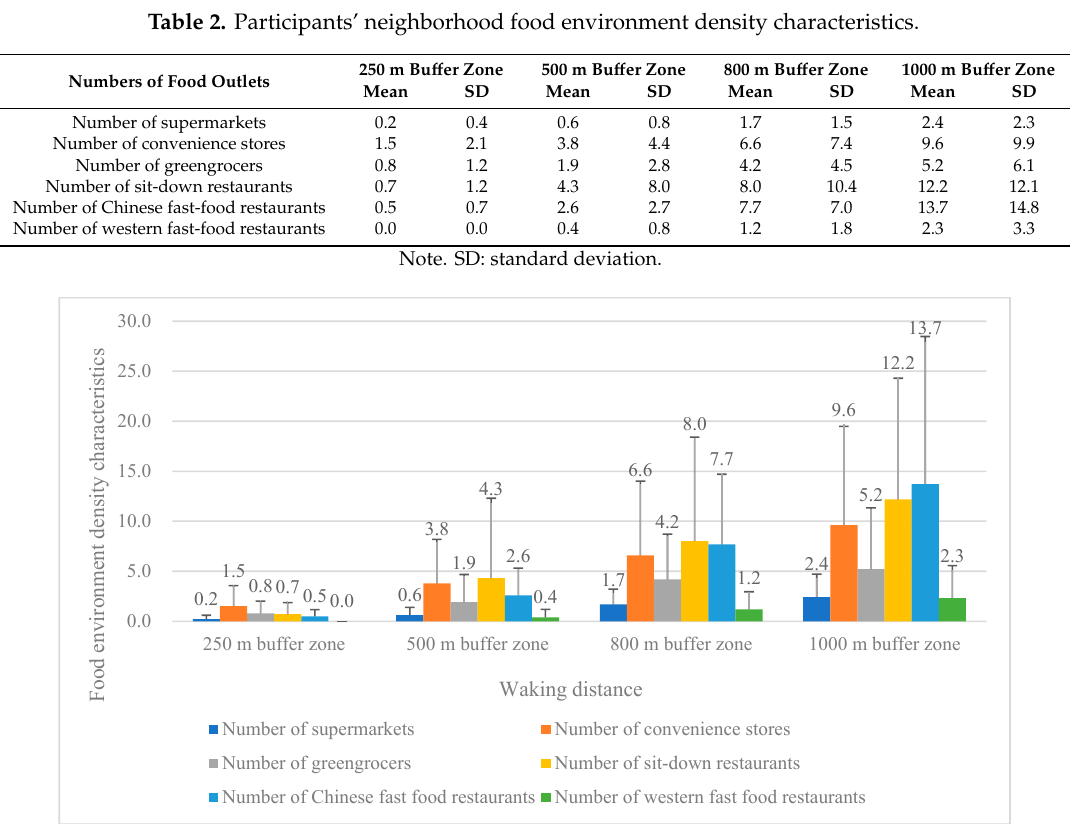
Table 2. Participants’ neighborhood food environment density characteristics.